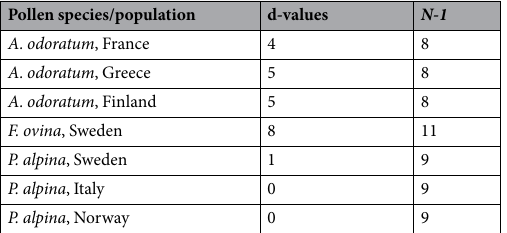
Pollen species/population d-values